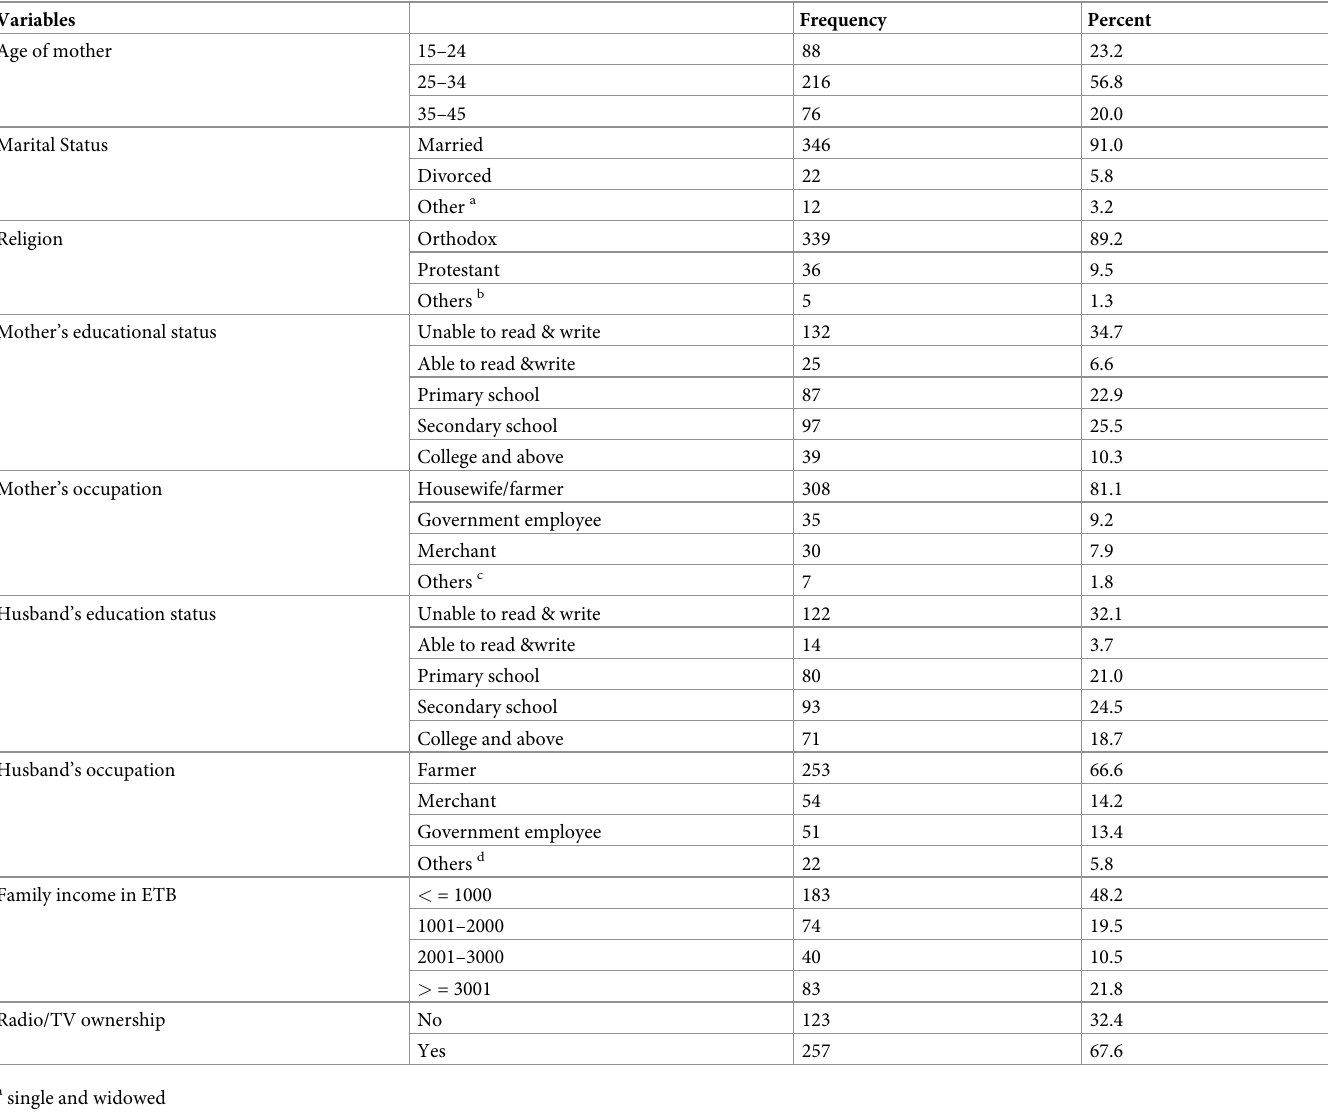
Table 1. Socio-demographic characteristics of the study participants at Debrelibanos district, north Showa, Oromia, and Ethiopia.